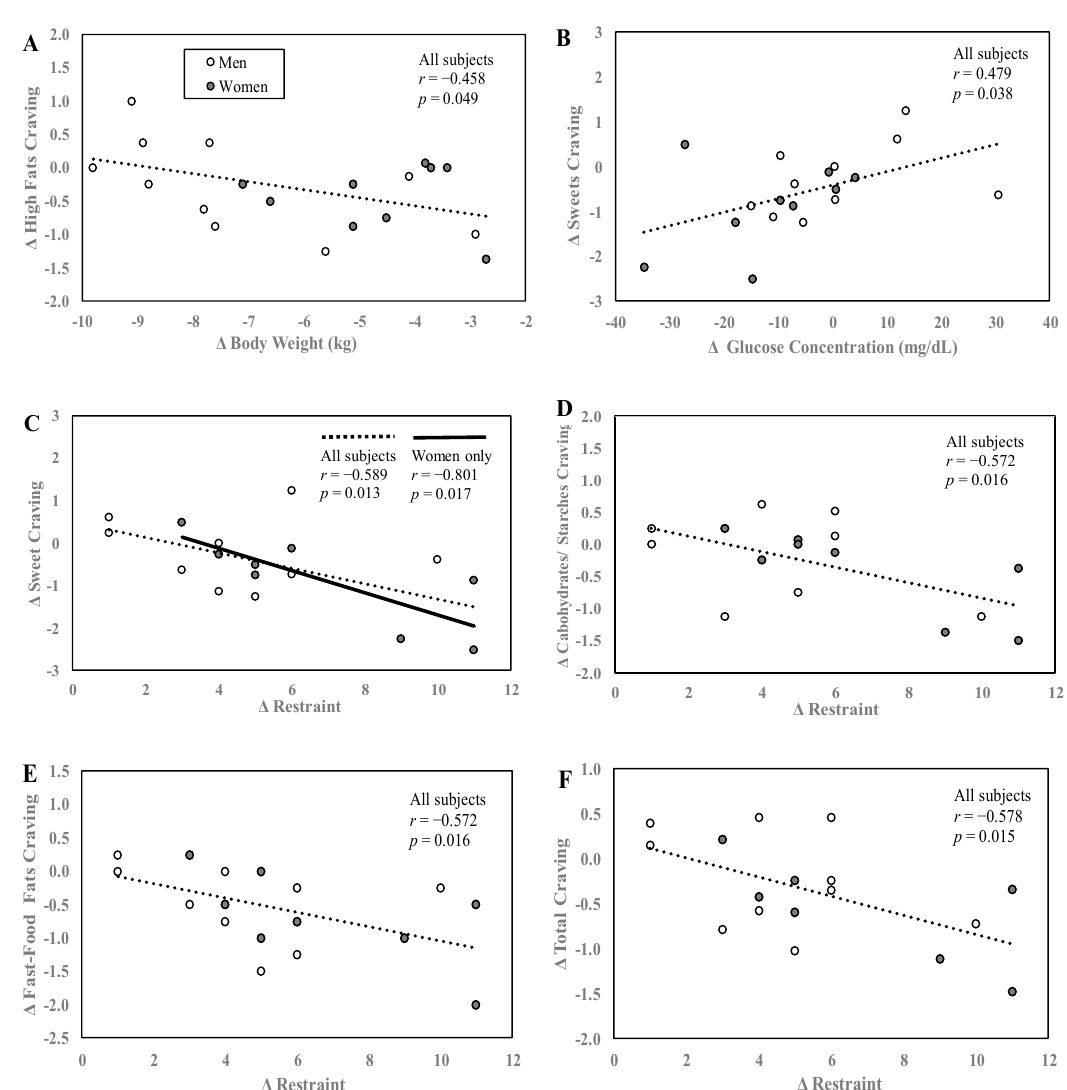
Figure 5. Relationships between craving scores, body weight, glucose concentrations, and eating behaviors. Correlations between change in high-fat cravings and change in body weight ( A ), change in sweet cravings and change in blood glucose concentration ( B ), and change in sweet, CHO / starches, fast-food fats, total cravings and dietary restraint ( C – F ). Change values were calculated by subtracting the value at baseline from week 4. Data are reported for N = 19 subjects that had complete data for cravings, body weight and glucose concentration ( A , B ) and N = 17 subjects who had complete data for both cravings and TFEQ ( C , D ). All significance tests were two-tailed.